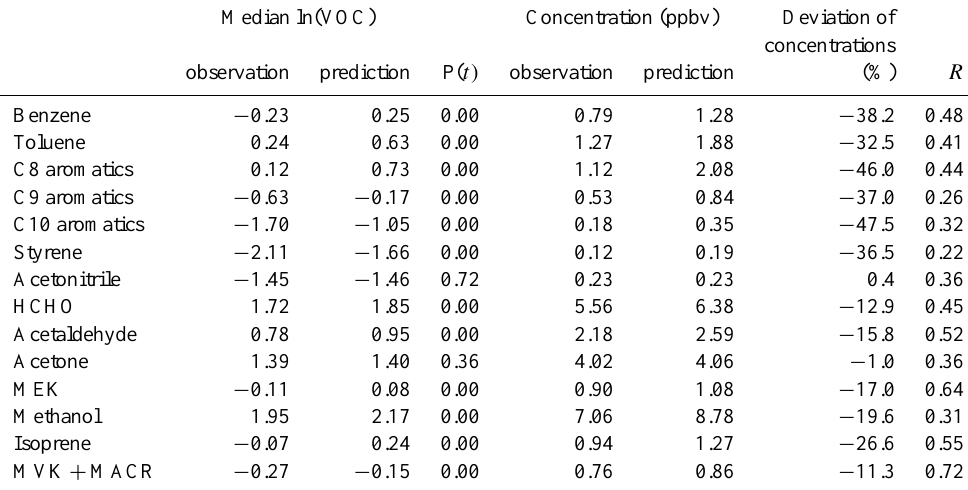
Table 2. Comparison of the observed and predicted values of median ln ( VOC ) and their corresponding concentrations during the full control period, and the deviations between observed and predicted concentrations, together with the outputs P( t ) from Student’s t test for the two data sets, where P( t )<0.05 implies that the difference in the two data sets is statistically significant at the confidence level of 95%. Median